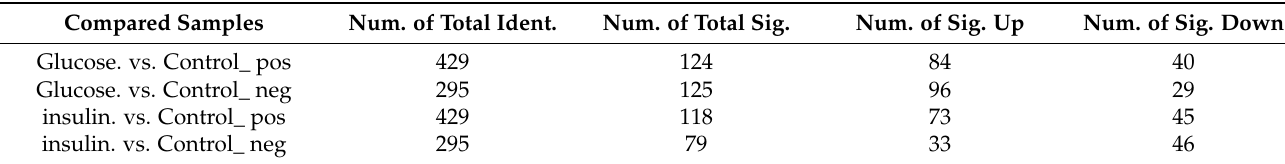
Table 1. Screening results of differential metabolites. Compared Samples Num. of Total